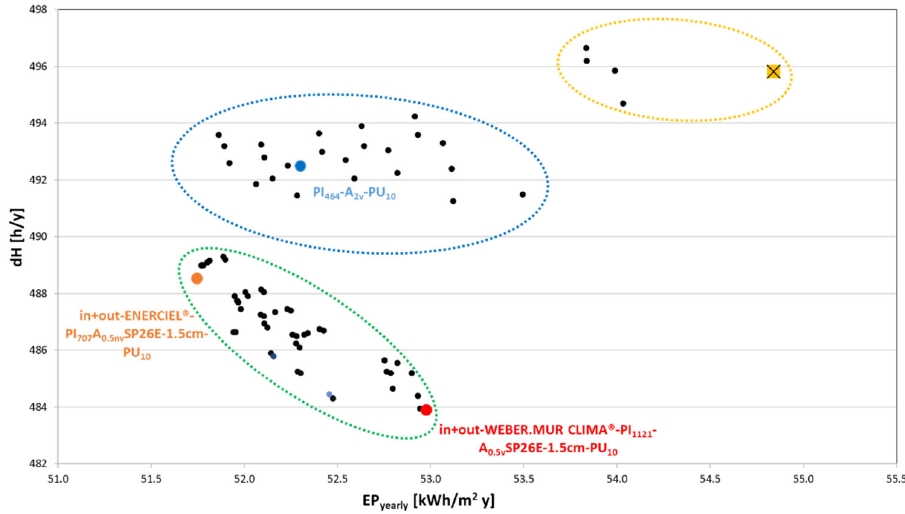
Figure 11. PCMs on both sides: comparison based on heating and cooling